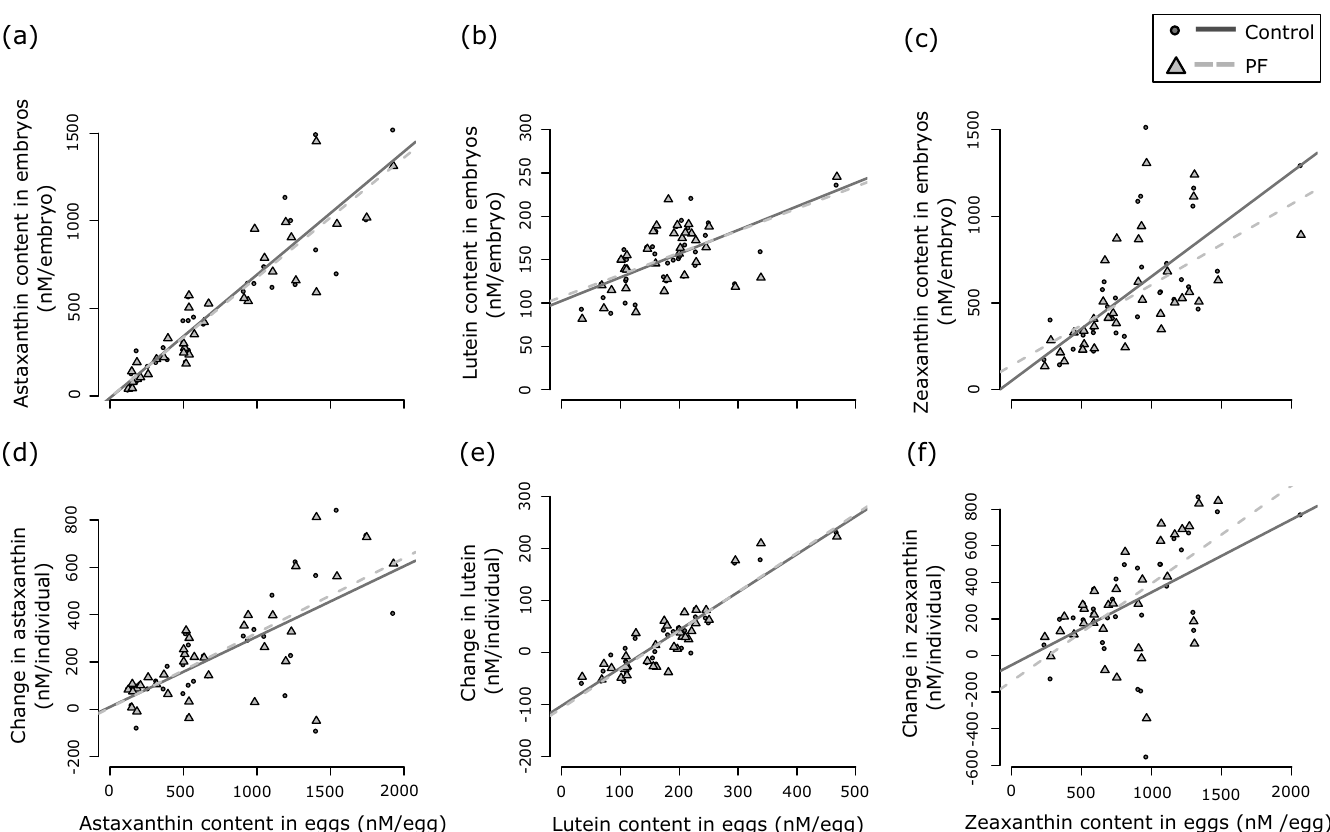
Fig 1. The relationship between carotenoid content in eggs and in embryos across maternal half sib families. Astaxanthin, lutein and zeaxanthin contents were measured before fertilization (“content in eggs”; data from Wilkins et al. [24]) and at a late-eyed development stage (“content in embryos”) in sham-treated controls (circles and solid regression lines) and after exposure to P . fluorescens (PF; triangles and dashed regression lines). Panels a-c show the relationship between carotenoid contents at the two different time points; and panels d-f the absolute changes in carotenoids relative to carotenoid contents before fertilization. See Table 1 for non- parametric statistics (the regressions lines are shown for